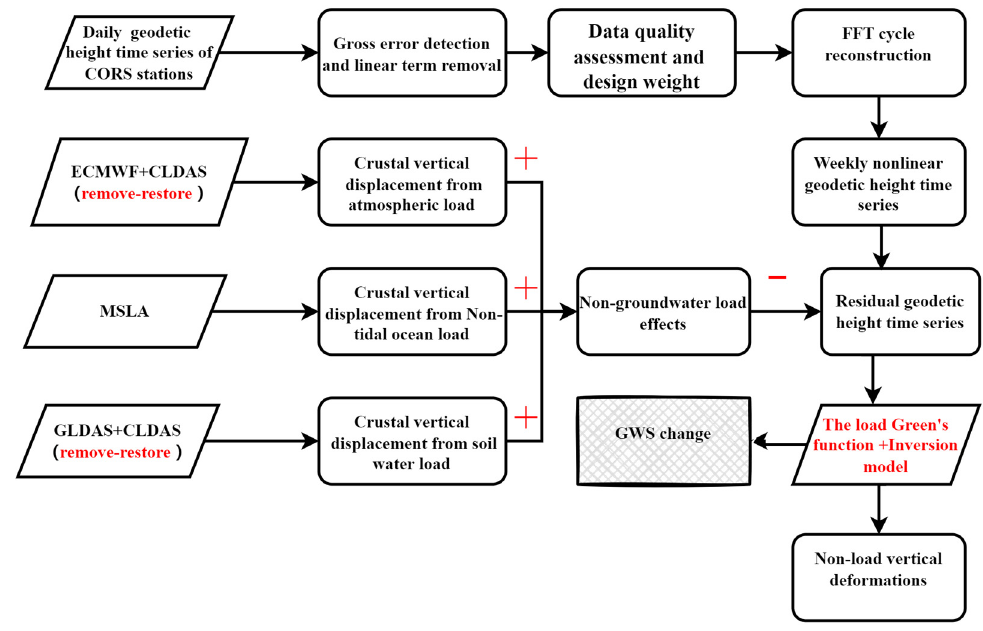
Figure 4. Flowchart of CORS inversion for GWSA.